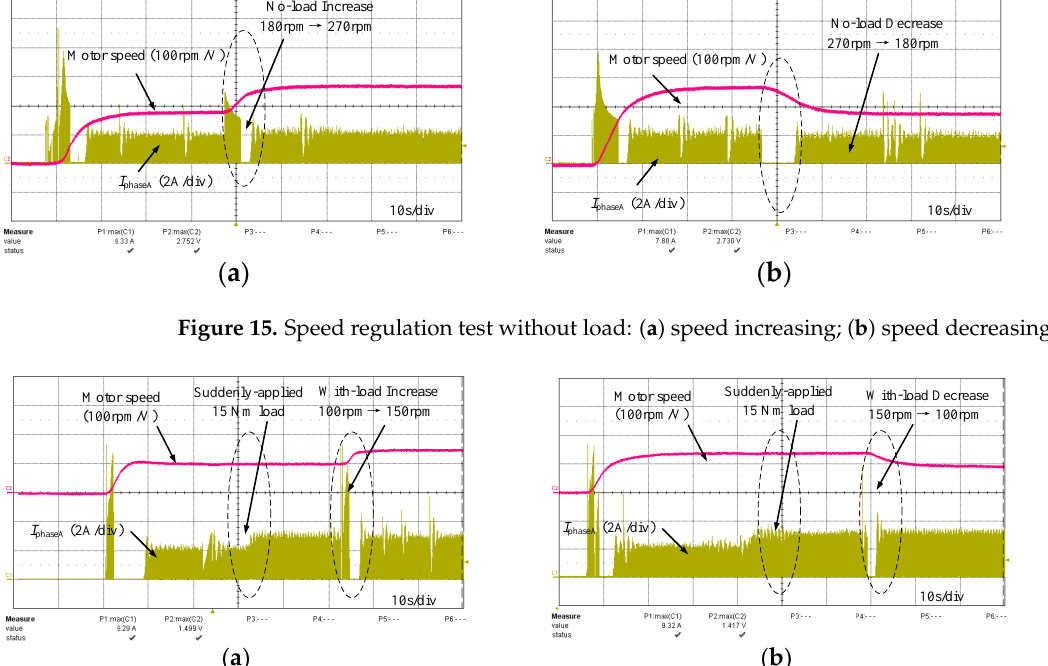
Figure 15. Speed regulation test without load: ( a ) speed increasing; ( b ) speed decreasing. Figure 16a shows the speed acceleration experiment with a 15 Nm load from 100 r/min to 150 r/min, and Figure 16b shows the deceleration experiment with the same load from 150 r/min to 100 r/min. When the motor starts up and runs stably, the motor can run Figure 16. Speed regulation test with load: ( a ) speed increasing; ( b ) speed decreasing.